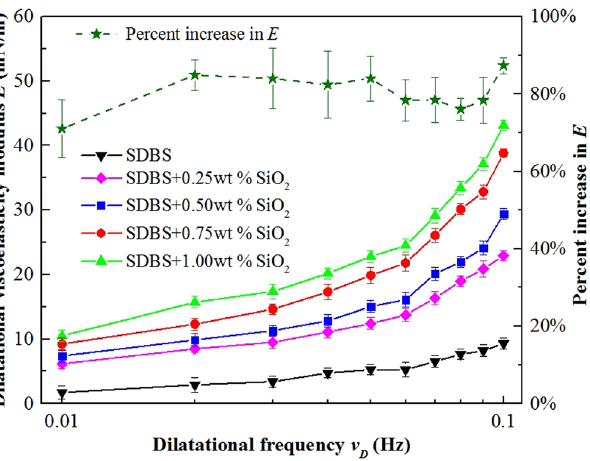
Figure 7. Dilatational viscoelastic modulus E of bubble surface as a function of dilatational frequency v D . SDBS concentration was 0.1 wt %. The percent increase in E between the lowest, 0.25 wt% SiO 2 , and the highest 1.00 wt%, SiO 2 , nanoparticle concentration calculated from Eq. 8 is plotted on the secondary